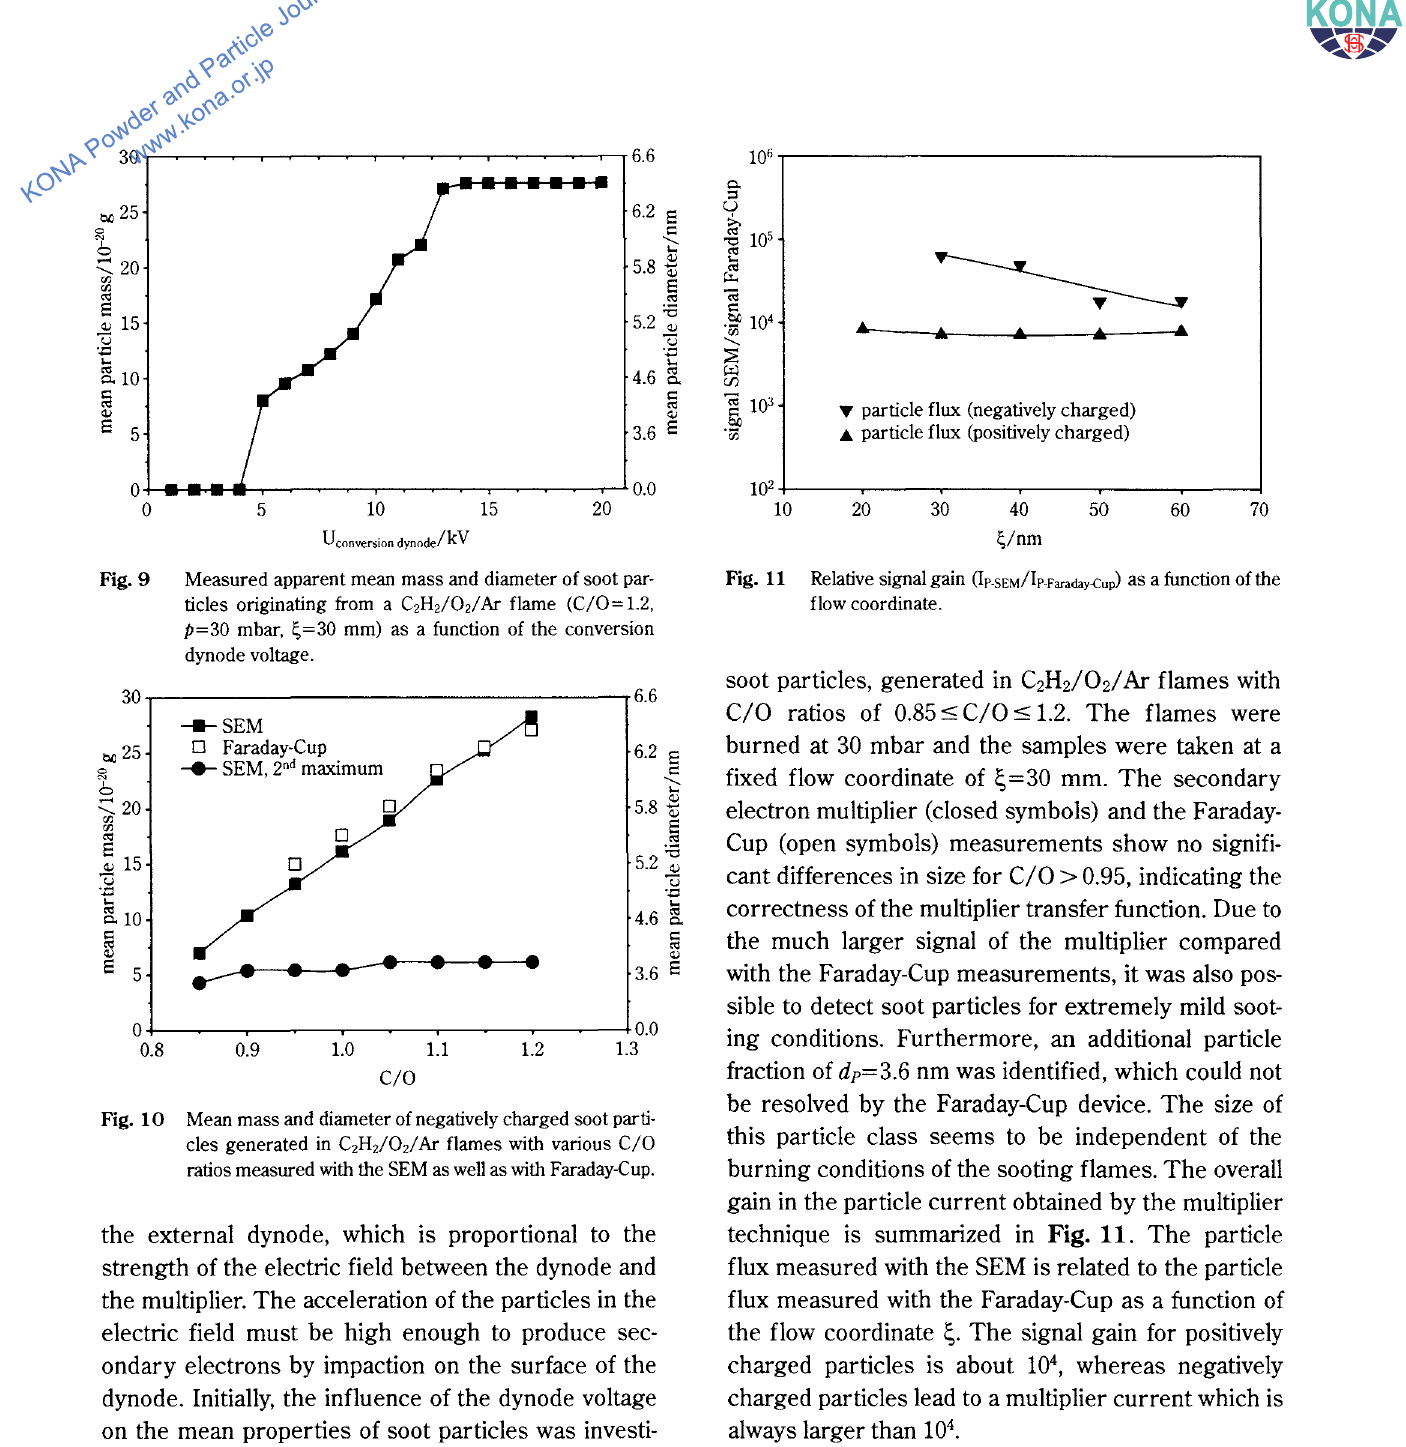
Fig. 9 Measured apparent mean mass and diameter of soot par ticles originating from a C 2 H 2 /0 2/ Ar flame (C/0= 1.2, P=30 mbar, ~=30 mm) as a function of the conversion dynode voltage. Fig. 10 Mean mass and diameter of negatively charged soot parti cles generated in C 2 H 2 /0 2/ Ar flames with various C/0 ratios measured with the SEM as well as with Faraday-Cup.